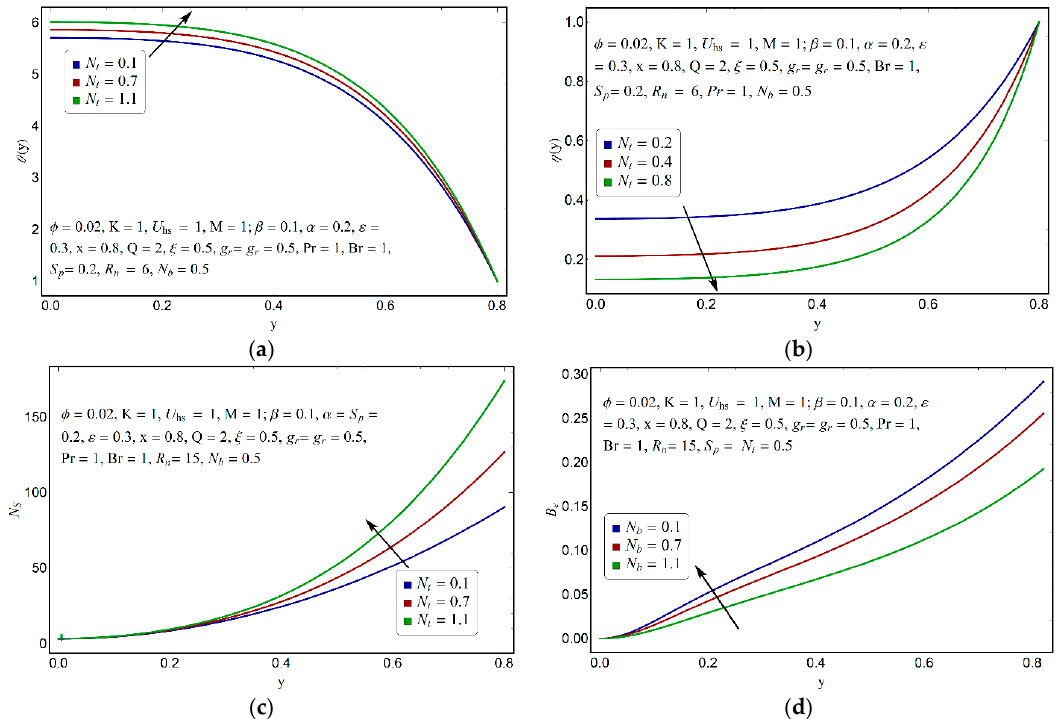
Figure 8. Impact of N b on ( a ) the temperature profile, ( b ) the mass concentration, ( c ) the entropy number, and ( d ) the Bejan number.